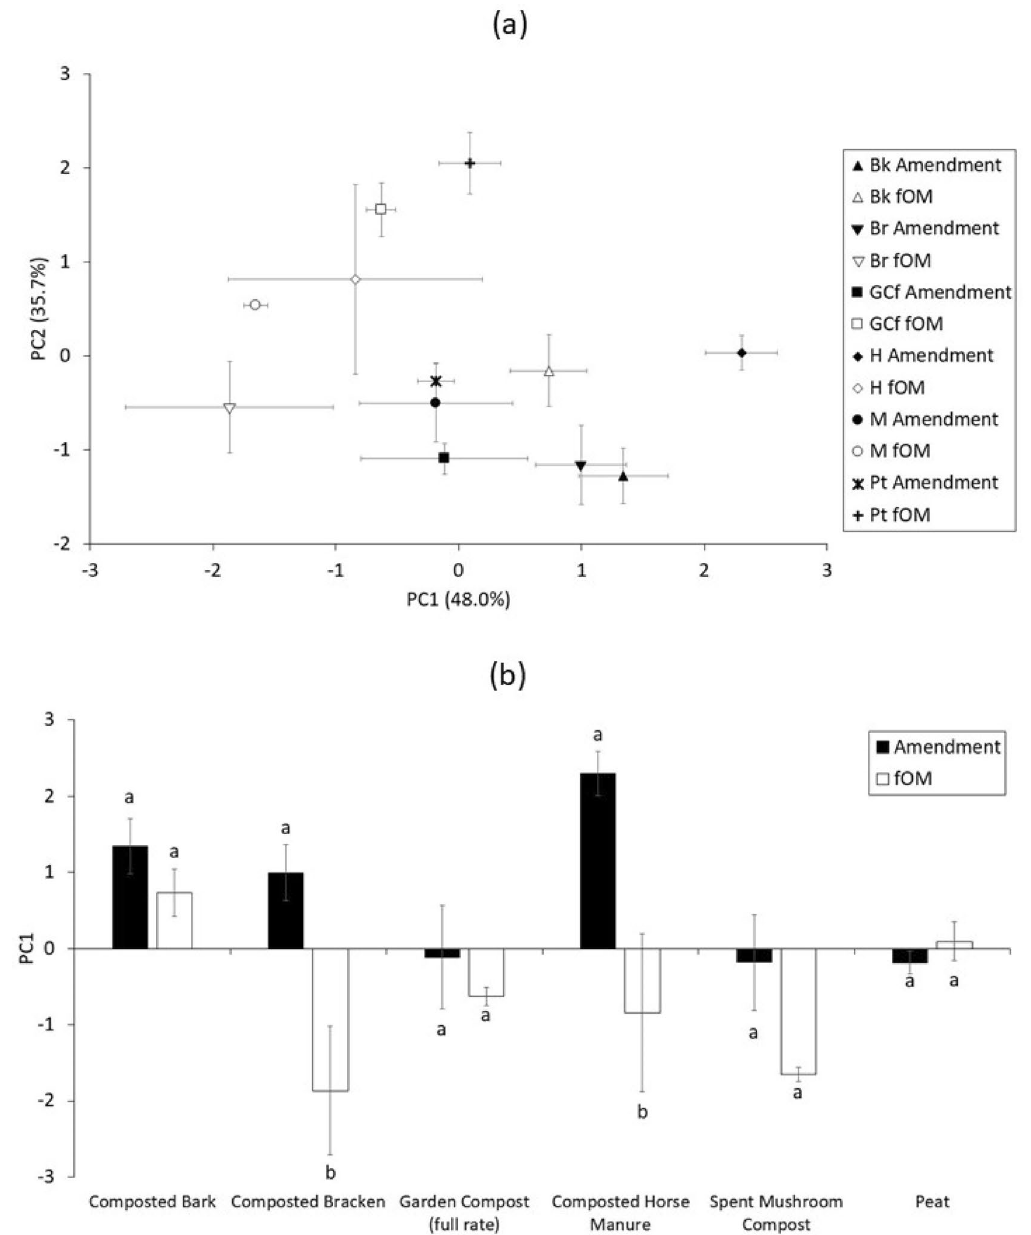
Figure 4. Principal components analysis of C integral functional groups in amendments applied and free organic matter (fOM) isolated a year later ( a ) Biplot of mean PC1 and PC2 for amendments and fOM (n = 3). Vectors for PC1: Alkyl C = − 0.52; O-Alkyl C = 0.71; Aromatic C = − 0.21; Carbonyl C = − 0.43. Vectors for PC2: Alkyl C = 0.58; O-Alkyl C = − 0.04; Aromatic C = − 0.70; Carbonyl C = − 0.41 ( b ) Scores for PC1 for each treatment. Bars within the same treatment that are labelled with the same lower case letter (a, b etc.) are not significantly different according to ANOVA and Tukey’s post hoc-testing ( p > 0.05). Error bars for standard error (n = 3). Samples: Bk composted bark, Br composted bracken, GCf garden compost (full rate), H composted horse manure, M spent mushroom compost, Pt